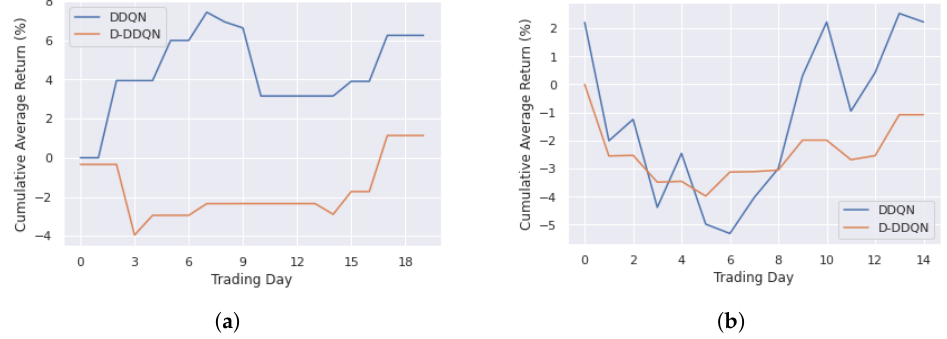
Figure 6. Cumulative average returns from DRL approach with return reward function. ( a ) Training period; ( b ) Testing